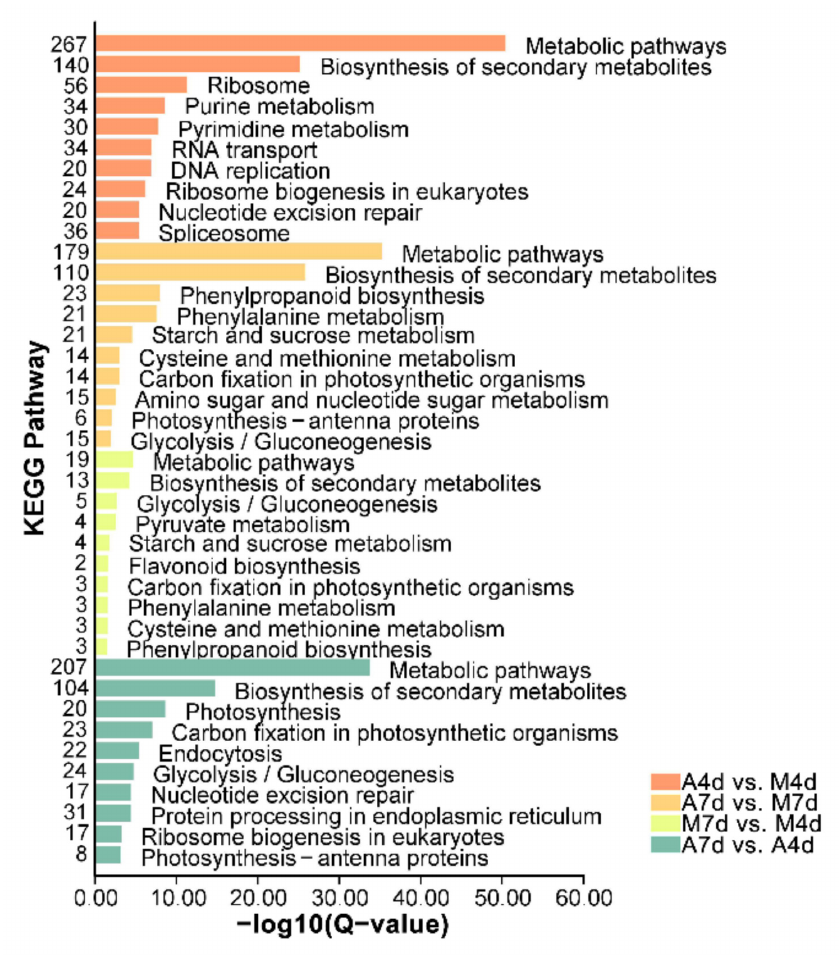
Figure 5. KEGG pathway assignments of DEGs were unique in A4d vs. M4d, A7d vs. M7d, M7d vs. M4d and A7d vs. A4d,